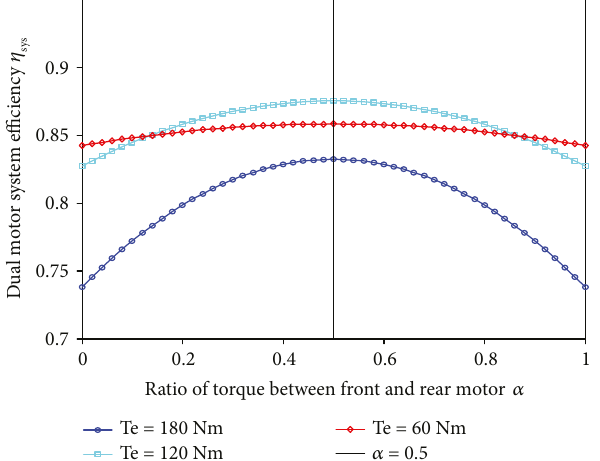
Figure 7: Schematic diagram of distribution at speed 1450 rpm.